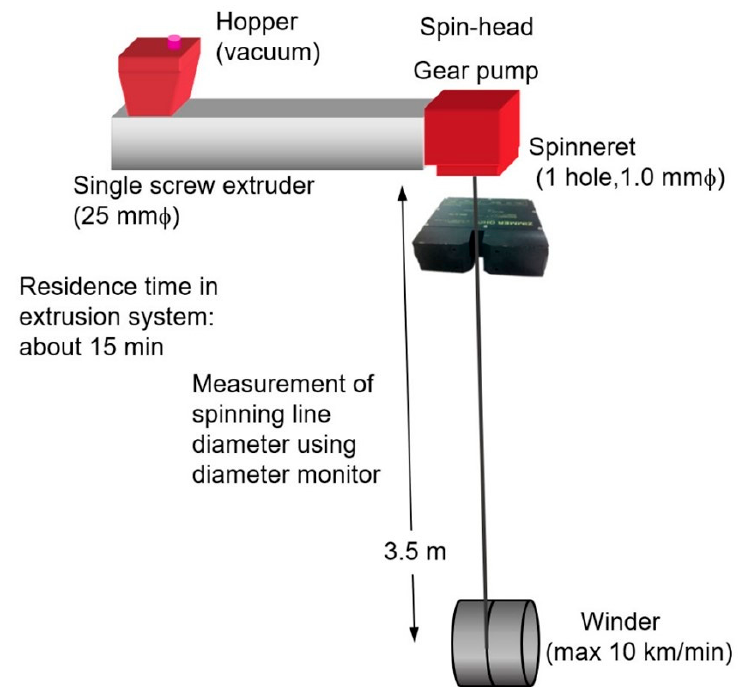
Figure 2. Schematic diagram of melt spinning apparatus.